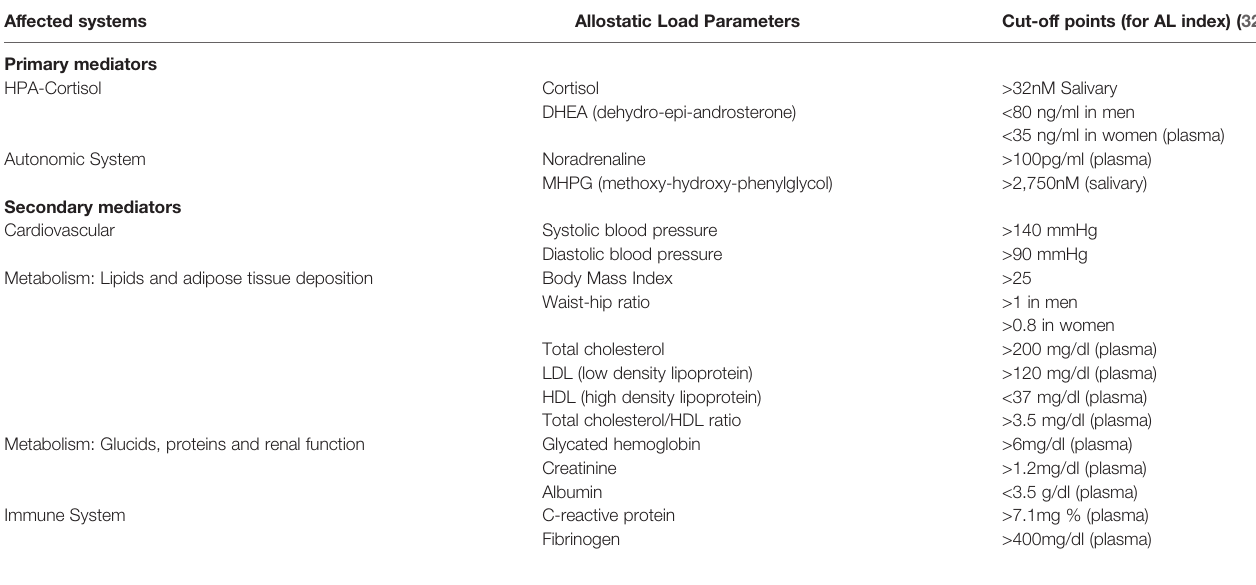
TABLE 1 | Allostatic load parameters and cut-off